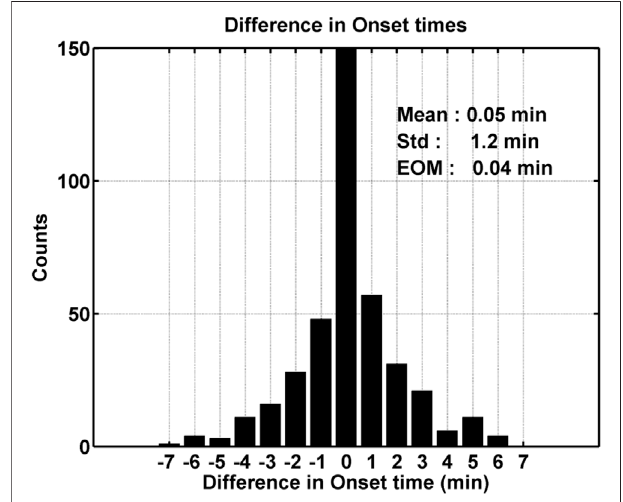
FIGURE 3 | Superposed epoch of cross covariance curves for SAL and NALindicesforover440onsetsidenti fi edintheSALindex.Epochtimezerois the onset time in the SAL index and the red horizontal dashed line is the full width half max of the peak of the cross correlation curve.